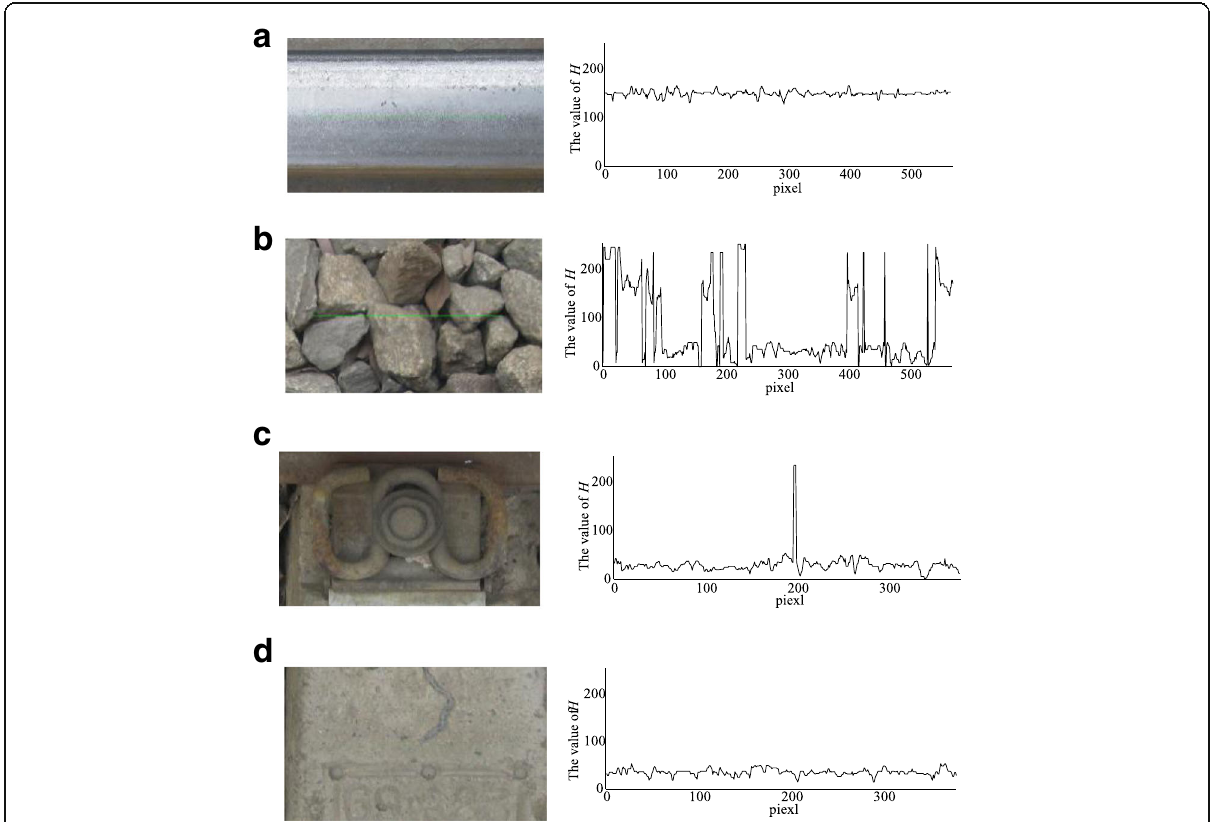
Fig. 2 H value curve of each part of orbit. a H value curve of a straight line in the rail region. b H value of a straight line in the ballast region. c H value curve of a straight line in the fastener region. d H value curve of a straight line in the sleeper